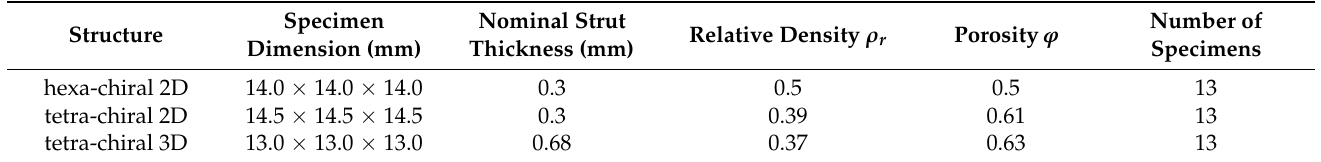
Table 2. Dimensions and material parameters of